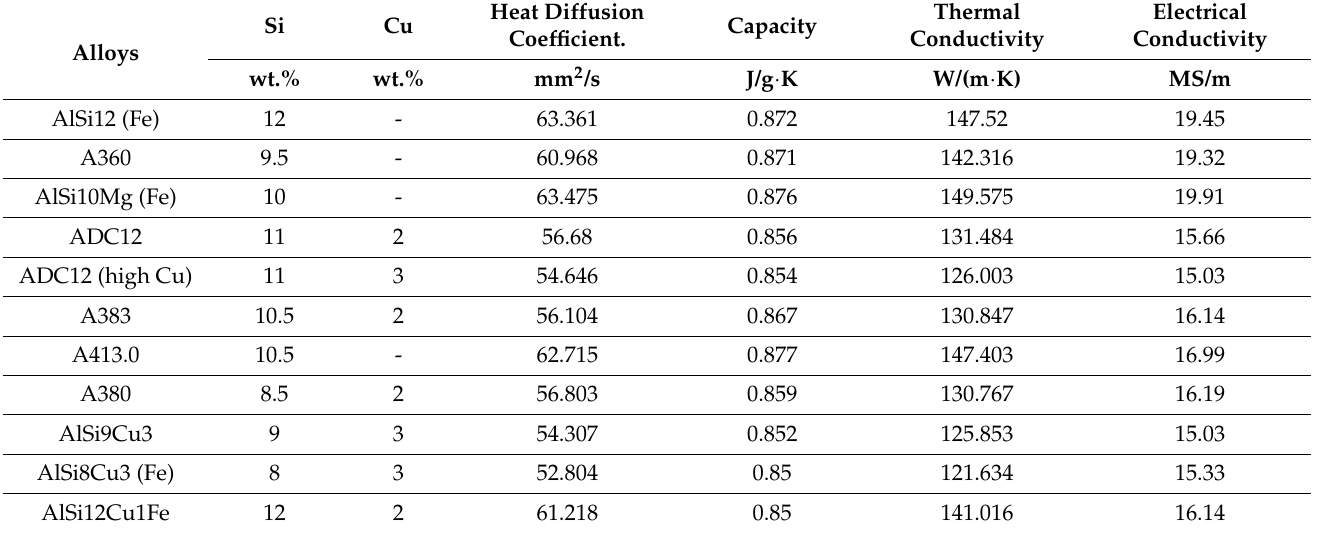
Table 1. The most commonly used commercial high conductivity Al-Si